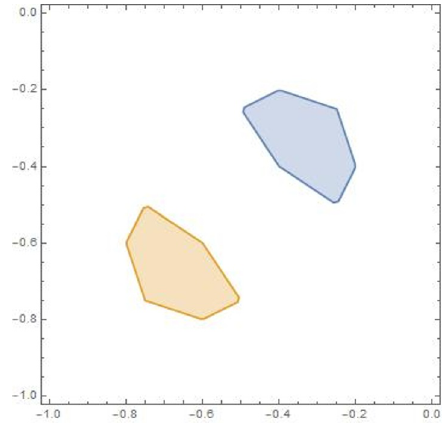
Figure 4 . The blue and yellow domains correspond to the domains in figure 3 that contain the unrefined points [ φ ] = − 1 and [ φ ] = − 2 3 3